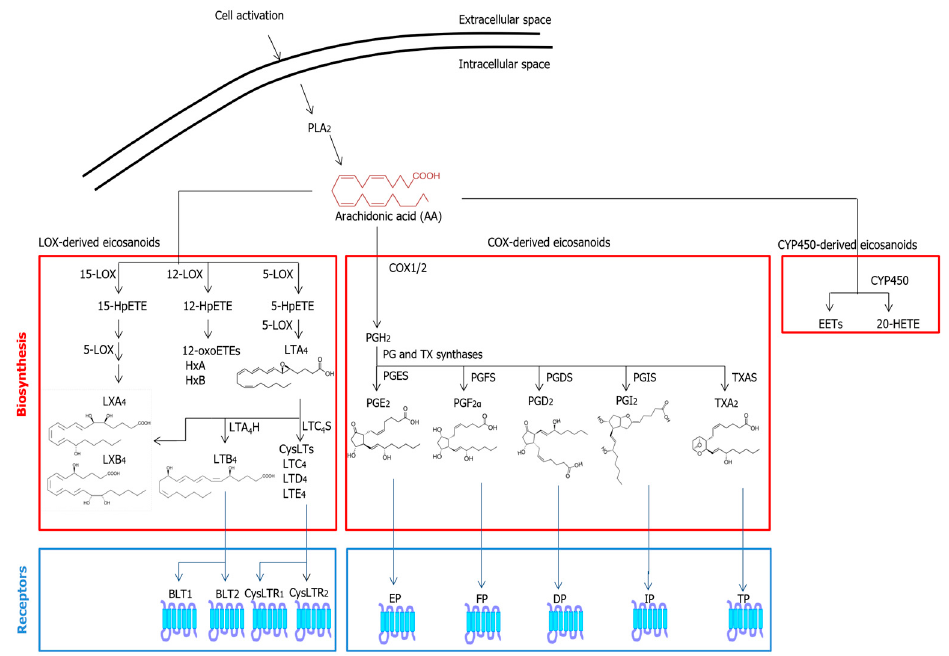
Figure 1. Metabolic pathways and known receptors of classical EICs. Abbreviations: 20-HETE—20- Metabolic pathways and known receptors of classical